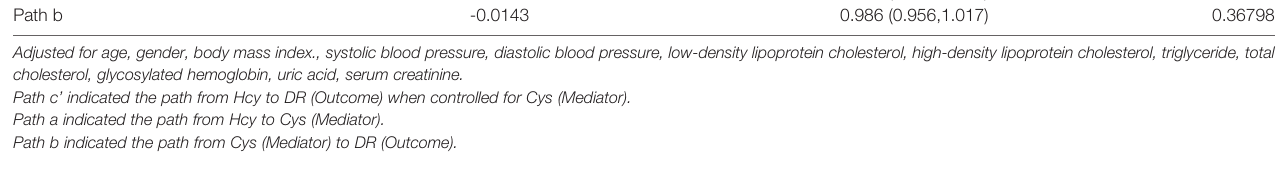
Adjusted for age, gender, body mass index., systolic blood pressure, diastolic blood pressure, low-density lipoprotein cholesterol, high-density lipoprotein cholesterol, triglyceride, total cholesterol, glycosylated hemoglobin, uric acid, serum creatinine. Path c ’ indicated the path from Hcy to DR (Outcome) when controlled for Cys (Mediator). Path a indicated the path from Hcy to Cys (Mediator). Path b indicated the path from Cys (Mediator) to DR